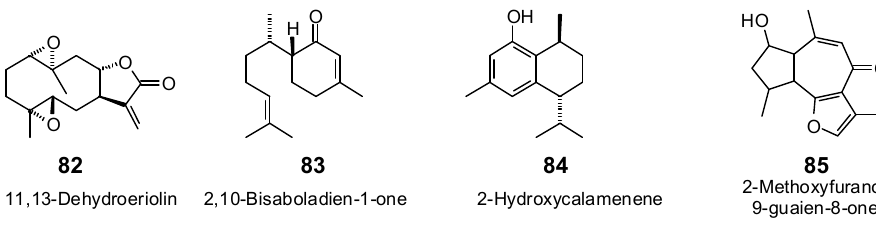
Figure 5. Monoterpenoids examined in this work.